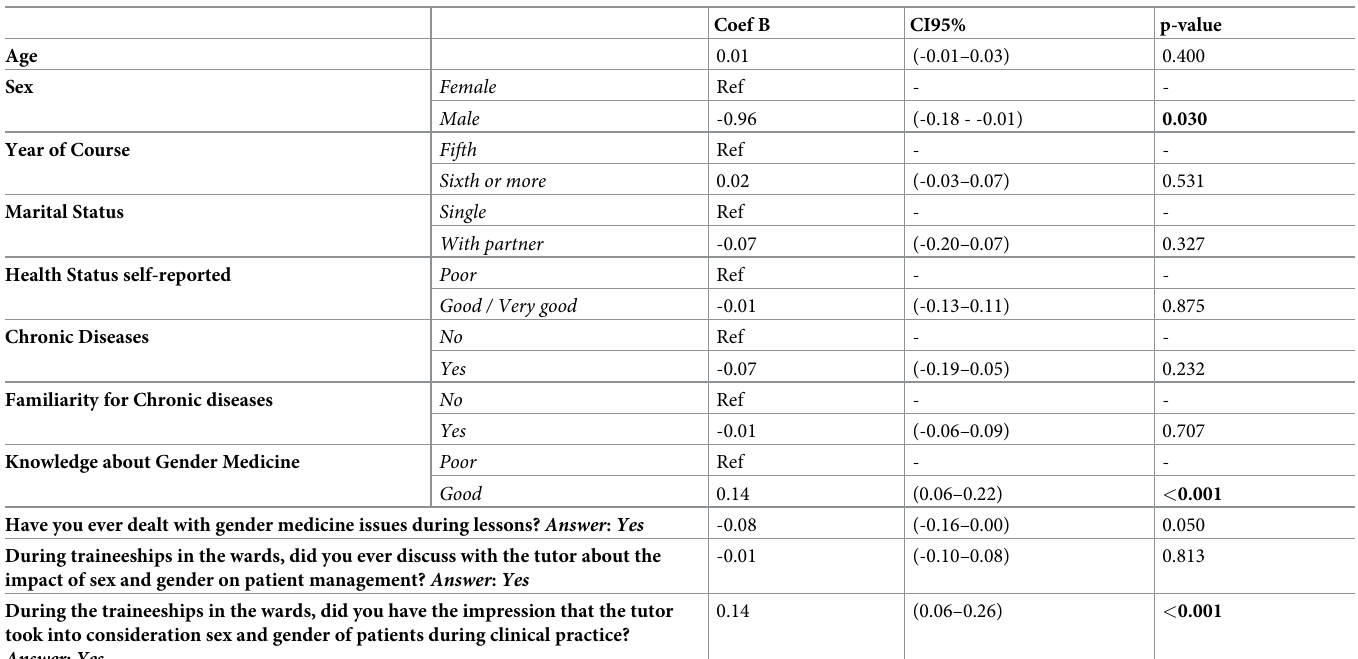
Table 3. Potential predictors of gender sensitivity.